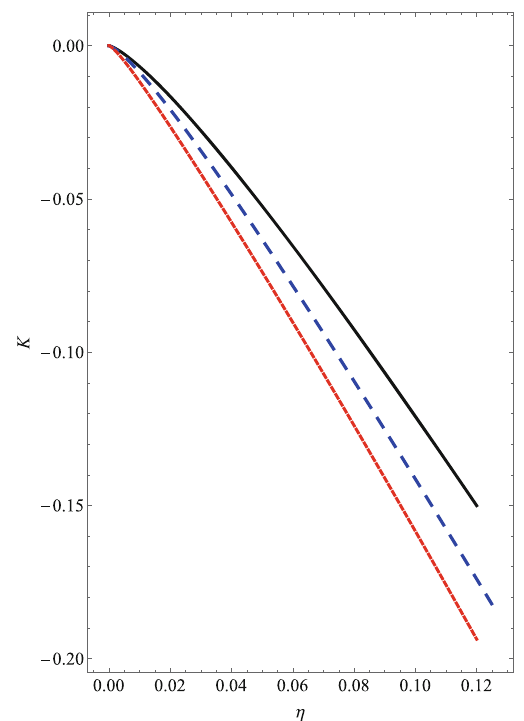
Fig. 9 Parametric plot of K as a function of η for y = 0 . 2 (black line), y = 0 . 25 (blue dashed line) and y = 0 . 3 (red dashed